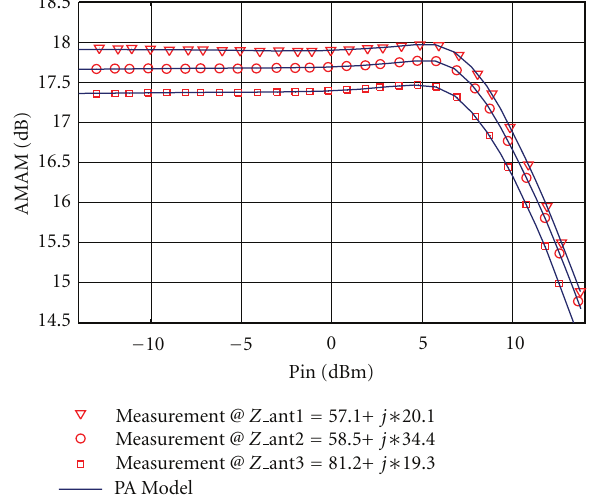
Figure 19: Gain compression (AMAM) versus input power for three calculated impedances (Z ant1 = 57 . 1 + j ∗ 20 . 1, Z ant2 = 58 . 5 + j ∗ 34 . 4 and Z ant3 = 81 . 2 + j ∗ 19 . 3) using the synthesis procedure. PA model (lines) compared to load pull measurement (symbols). F 0 = 8 . 2 GHz.